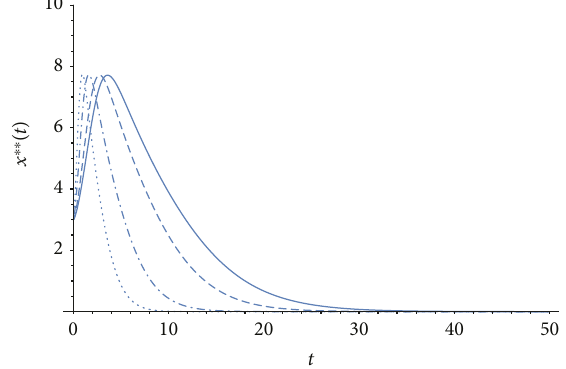
Figure 3: The graph represents the solution behavior the variable x ⋆⋆ t (concentration of double infected cells) versus time t under di ff erent values of the order of derivative. The solid line, dashed line, dot-dashed line, and dotted line represent solution behavior at ζ = 1, ζ = 0 75, ζ = 0 85 , and ζ = 0 95 ,